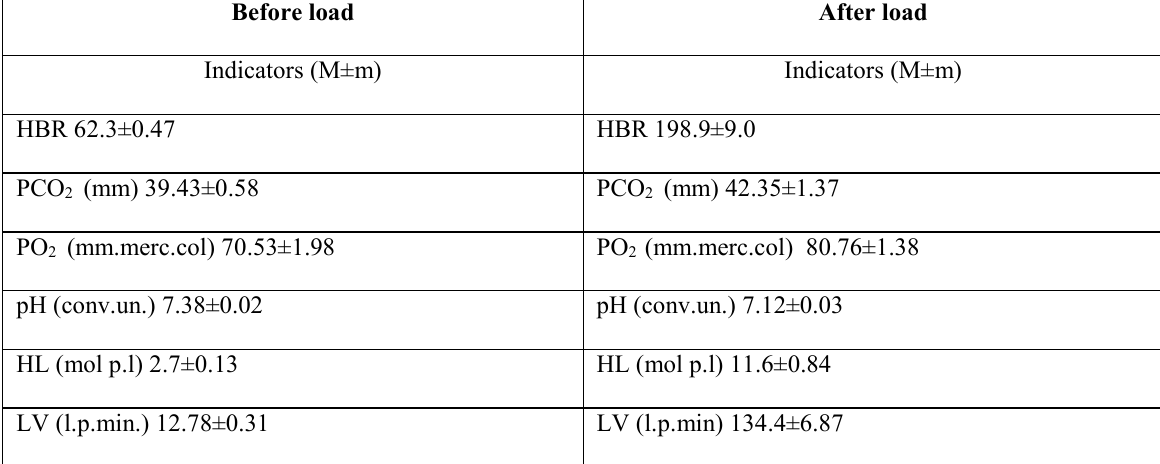
Indicators of maximal physiological and bio-chemical reactions of 400 meters hurdles-runners before and after work on treadmill